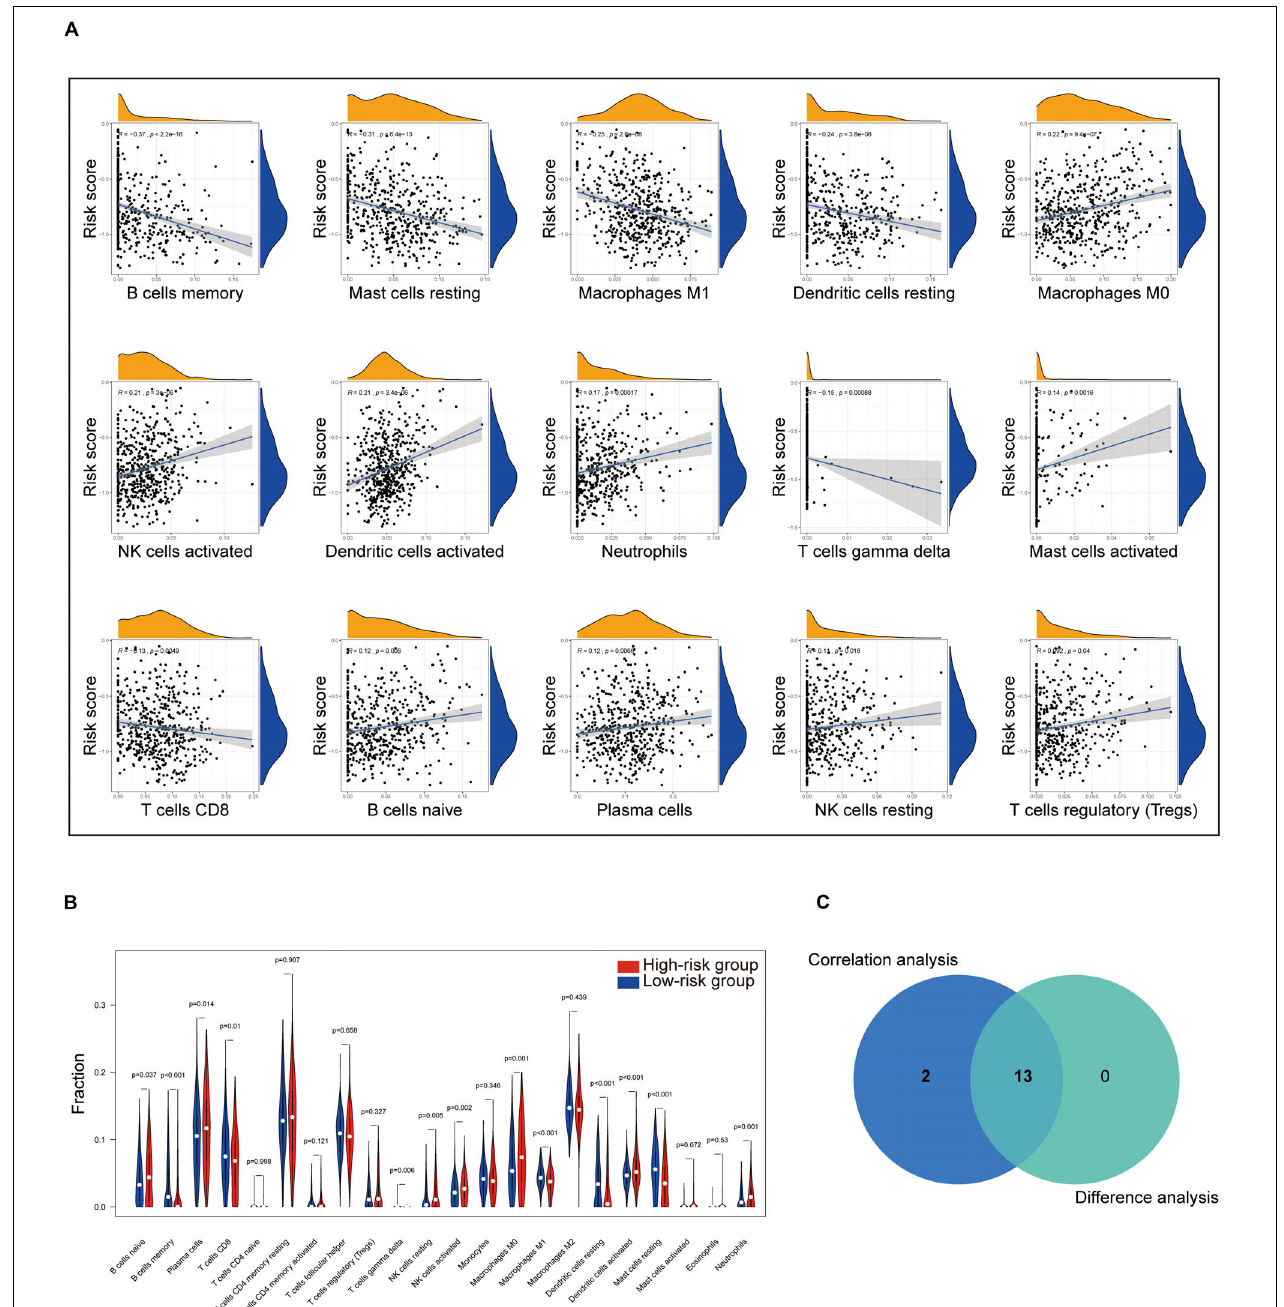
FIGURE 8 | Correlation of TICs proportion with eight-gene signature risk score in the training cohort. (A) Only significantly correlated TICs were plotted. The blue line in each plot was fitted linear model indicating the proportion tropism of the immune cell along with risk score. The shade around the blue line represents the 95% confidence interval. The Spearman coefficient was used for the correlation test. (B) The violin plot shows the ratio differentiation of 22 kinds of immune cells between LUAD tumor samples with the low- or high-risk group to the median of risk score, and the Wilcoxon rank sum was used for the significance test. (C) Venn plot displaying 13 kinds of TICs correlated with risk score co-determined by difference and correlation tests shown in violin and scatter plots, respectively. P value < 0.05 is the cutoff. TIC, tumor-infiltrating immune cell; LUAD, lung